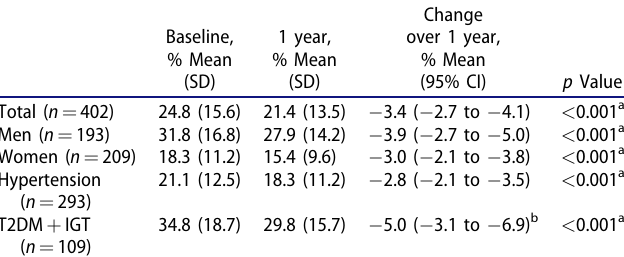
Table 3. Estimated 10-year risk of developing CVD according to framingham risk score at baseline, 1year, and change over 1year. Baseline, % Mean